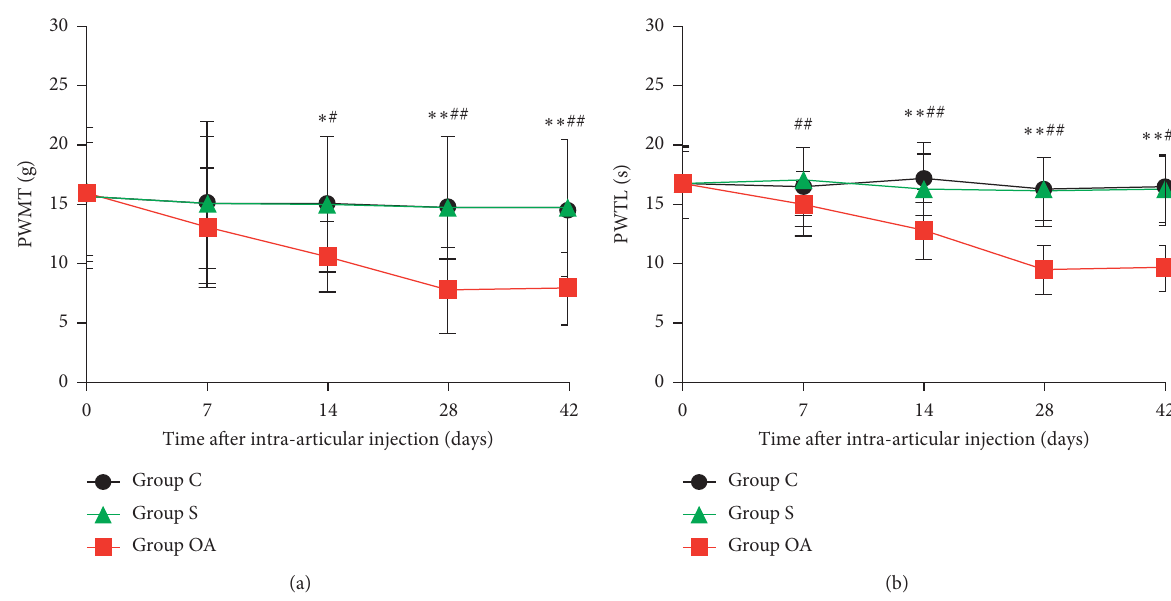
Figure 1: Comparison of PWMT (a) and PWTL (b) in the three groups of rats at each time point. Each symbol represents mean ± SD (standard deviation), n � 12 per group; ∗ P < 0.05, ∗∗ P < 0.01 vs. group C; # P < 0.05, ## P < 0.01 vs. baseline in the OA group. Repeated measures ANOVA: (a) multiple groups; (b) multiple groups ×